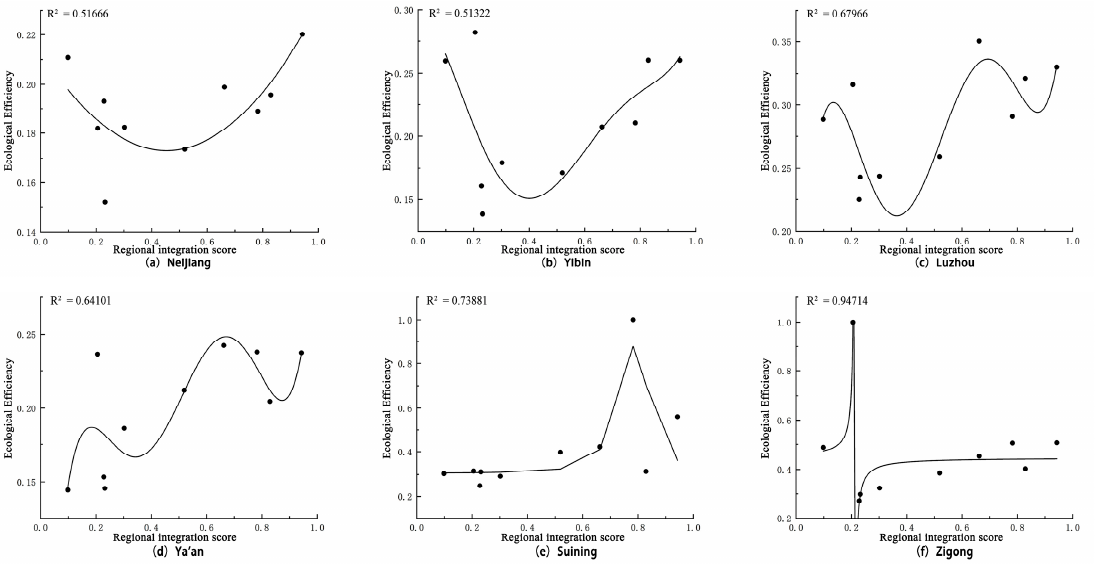
Figure 6. Regional integration of the CCUA does not improve the EEs of a few cities during 2011 to 2020.